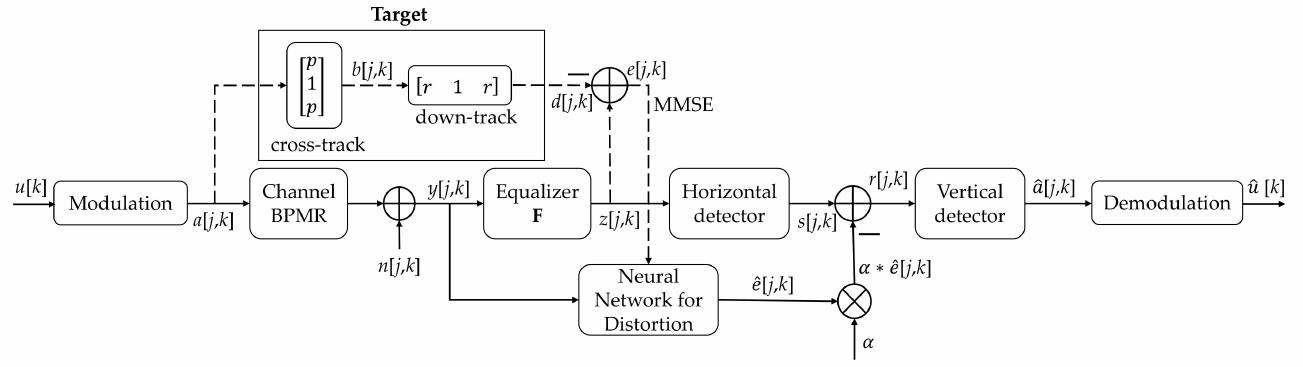
Figure 13. The noise power compensation